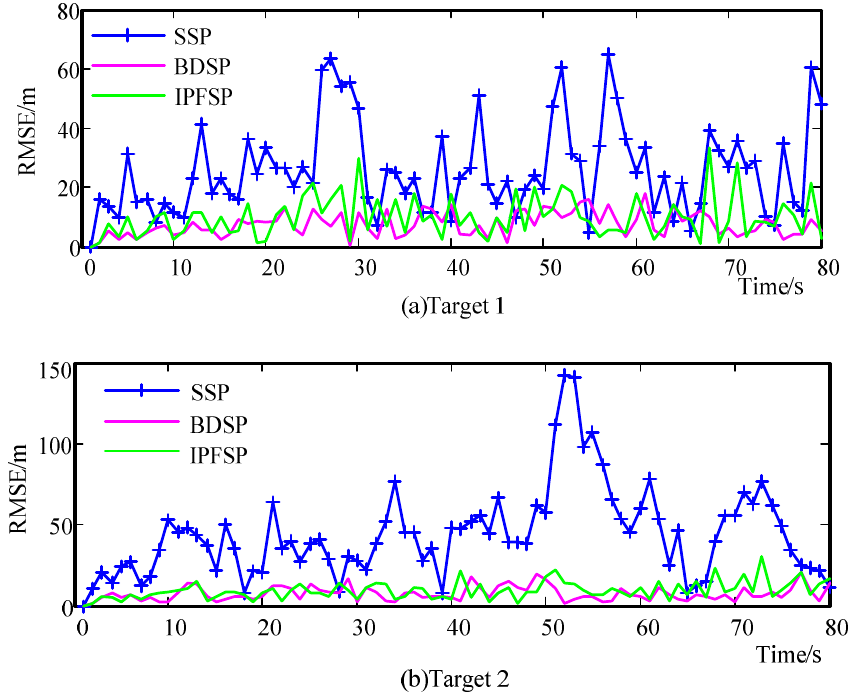
Figure 11 . RMSE of the target position under different scheduling policies. ( a ) Target 1; ( b ) Target 2.